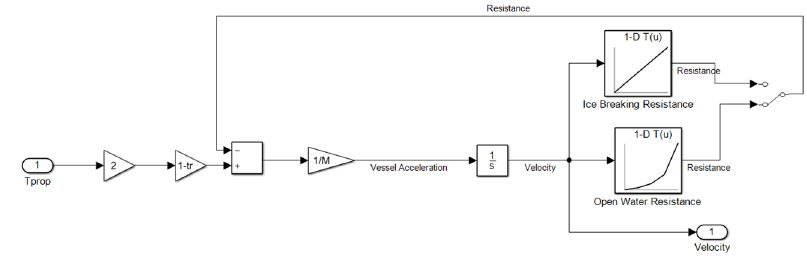
Figure 8. Hull dynamics model implemented in Simulink TM .